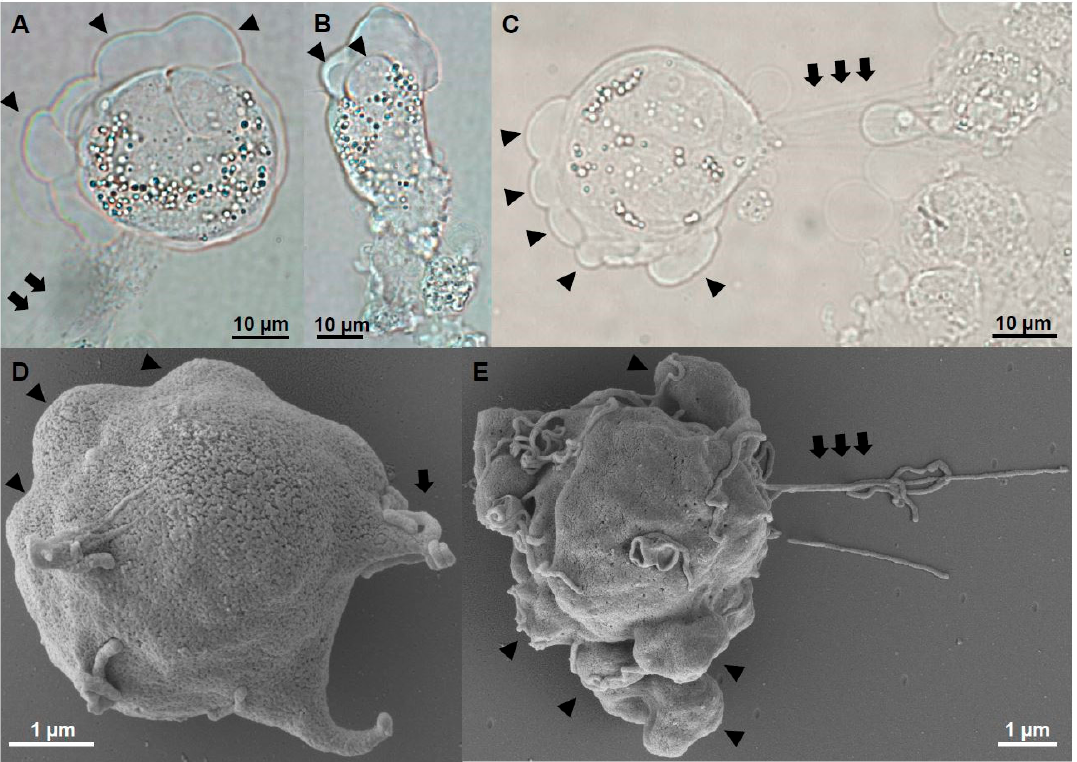
Figure 6. Motile stages of Ceratonova shasta genotype I from ascites of Chinook salmon. ( A – E ) Stages showed profuse blebbing at the anterior end and a posterior end with extensible filaments, which anchored the stage to other cells. Head arrows: blebs, Arrows: filaments. A – C , Light microscopy. D , E , SEM.